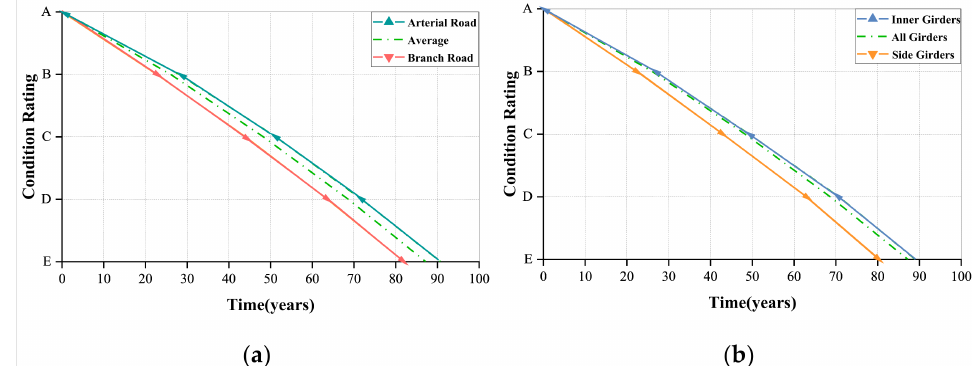
Figure 3. Effect of two factors on the life of the main girders. ( a ) road factor; ( b ) position factor.